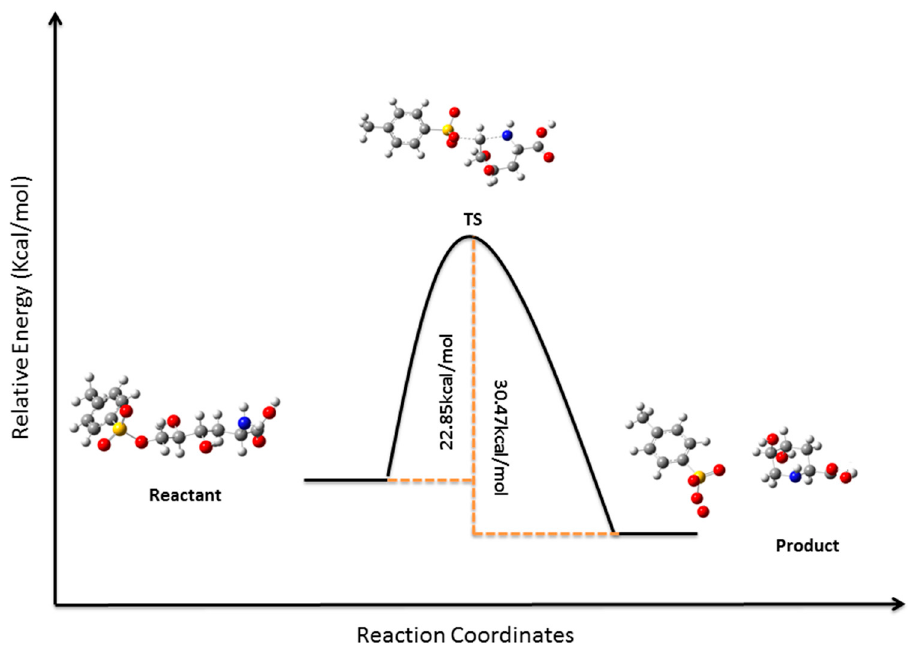
Figure 4. Minimum energy conformations, activation energy, and transition state for the intramolecular ring closure of intermediate 12a to obtain 1 (DFT, Gaussian 9.0) [28].